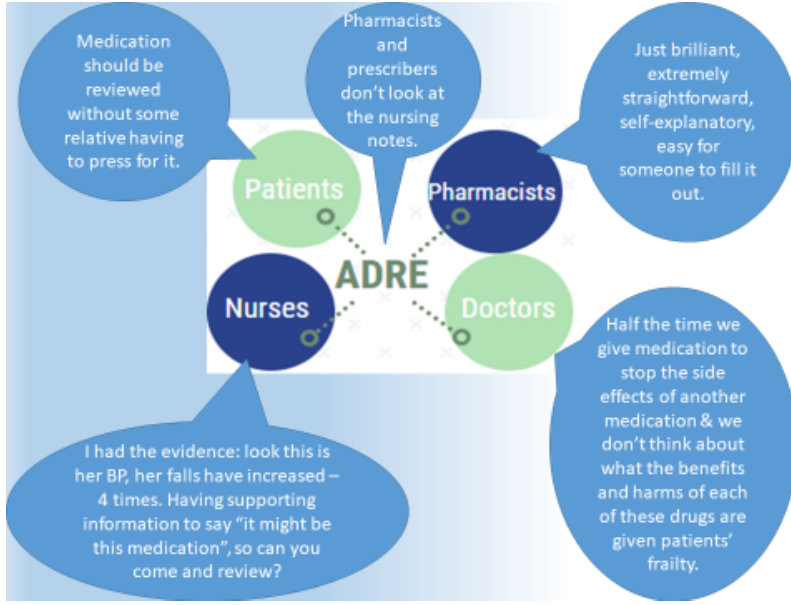
Figure 1. The adverse drug reaction profile (ADRe): some stakeholder opinions. These previously unpublished quotations come from 30 qualitative interviews with service users, care home staff and professionals completed in our 2019 study [6,7]. In brief, we interviewed nurses and residents (or family) from 10 care homes, as well as a range of stakeholders, including pharmacists and prescribing doctors, to identify the barriers and facilitators to using ADRe in real-world settings. The methods are detailed elsewhere [7].